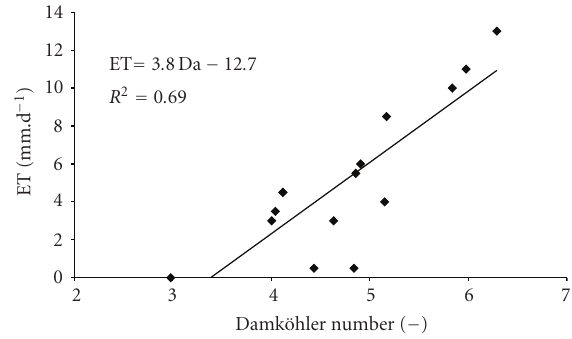
Figure 5: Relationship between Damk¨ohler number and ET for TKN degradation (except for R3 and